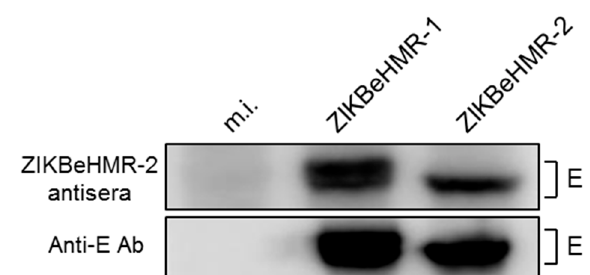
Figure 6. Anti-ZIKBeHMR-2 antibodies recognize the E protein from ZIKBeHMR-1. Vero cells